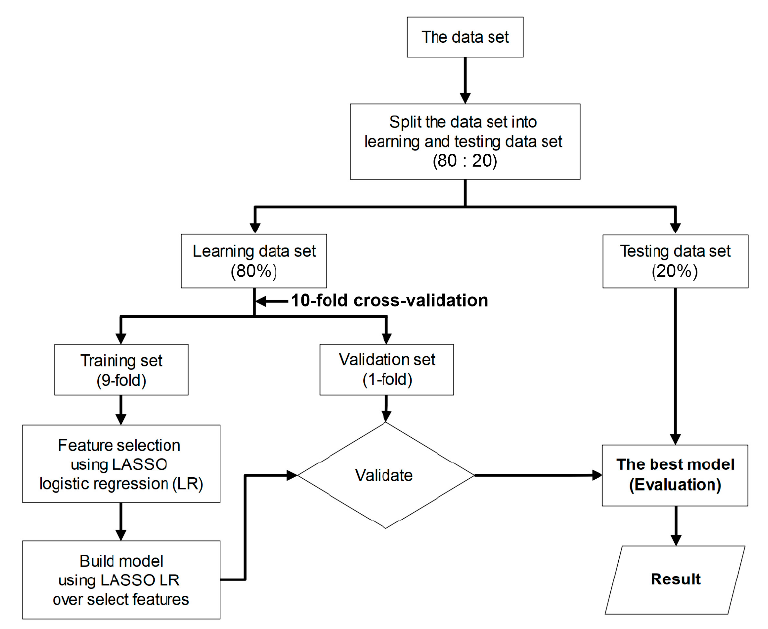
Figure 4. Flowchart of the machine-learning procedure used to evaluate the performance of classifi- cation models.